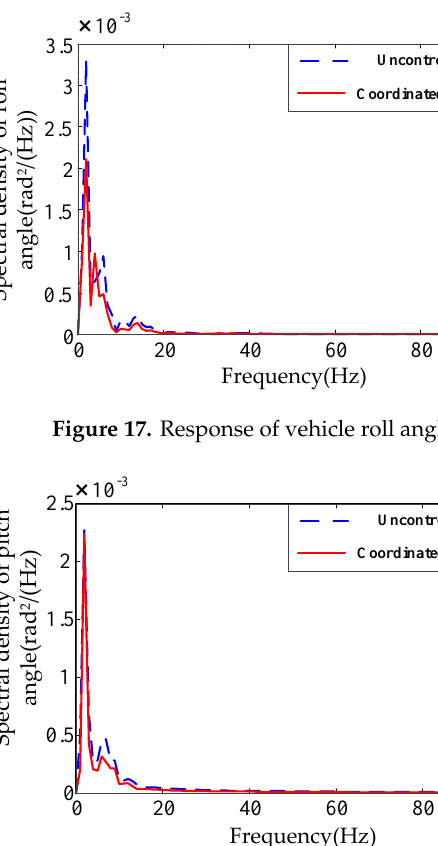
Figure 16. Response of vehicle vertical acceleration.